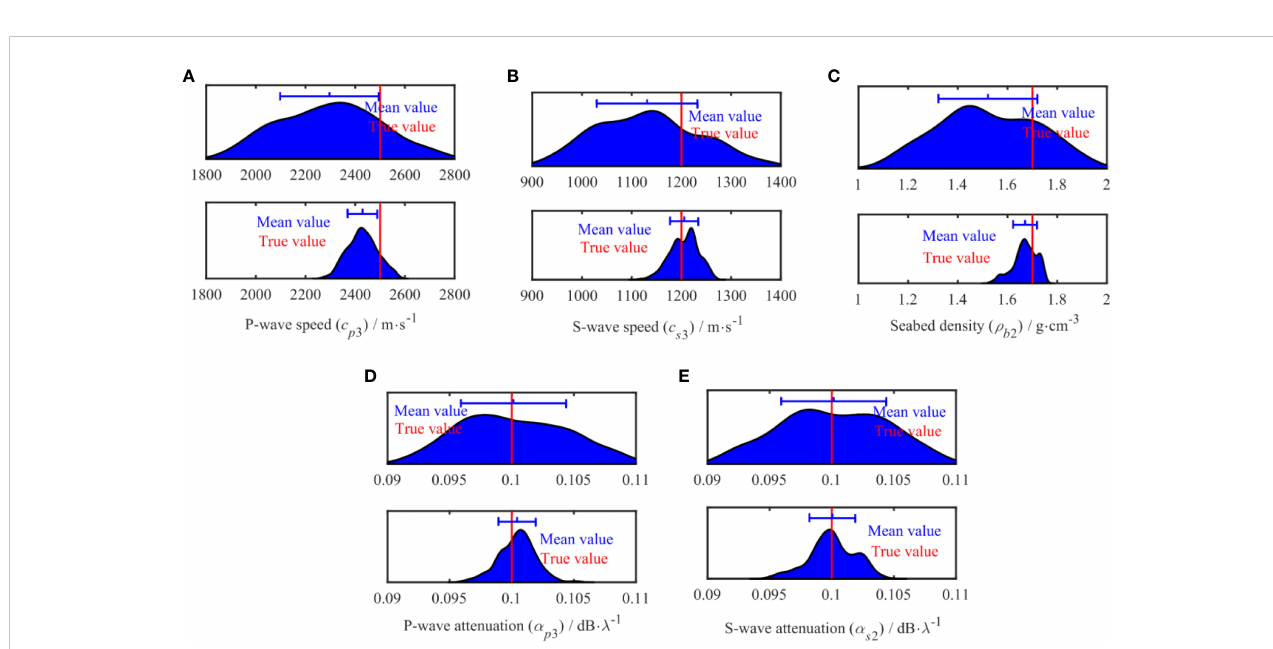
FIGURE 6 One-dimensional marginal probability distribution of sedimentary parameters.